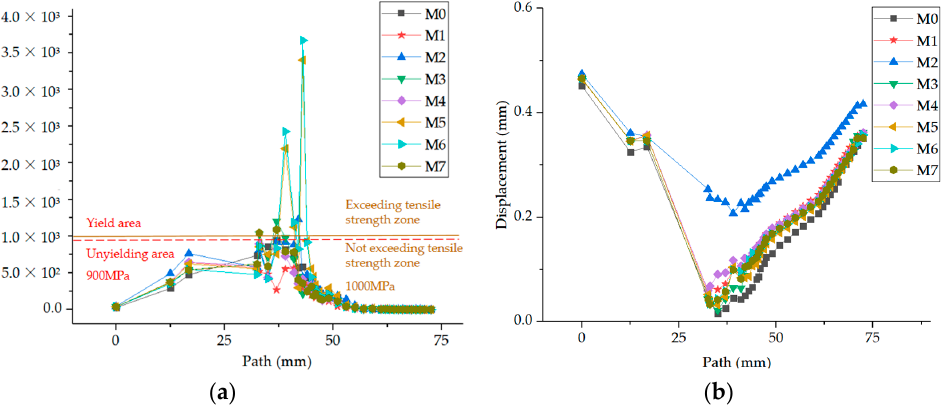
Figure 12. Distribution of stress S and displacement U of cracked bolt along path: ( a ) Path stress distribution of cracked bolt under seismic load; ( b ) Path displacement distribution of cracked bolt under seismic load.